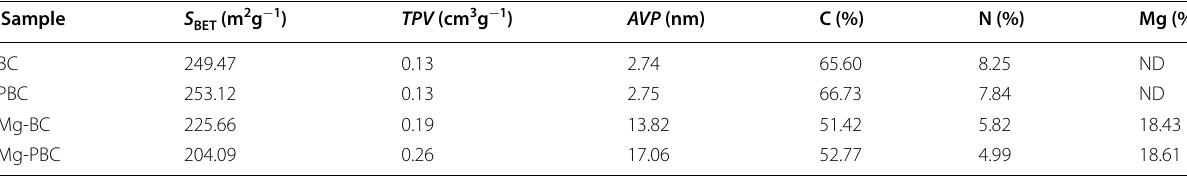
ND means not detected